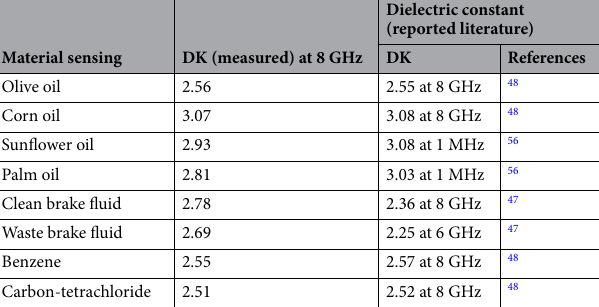
Material sensing DK (measured) at 8